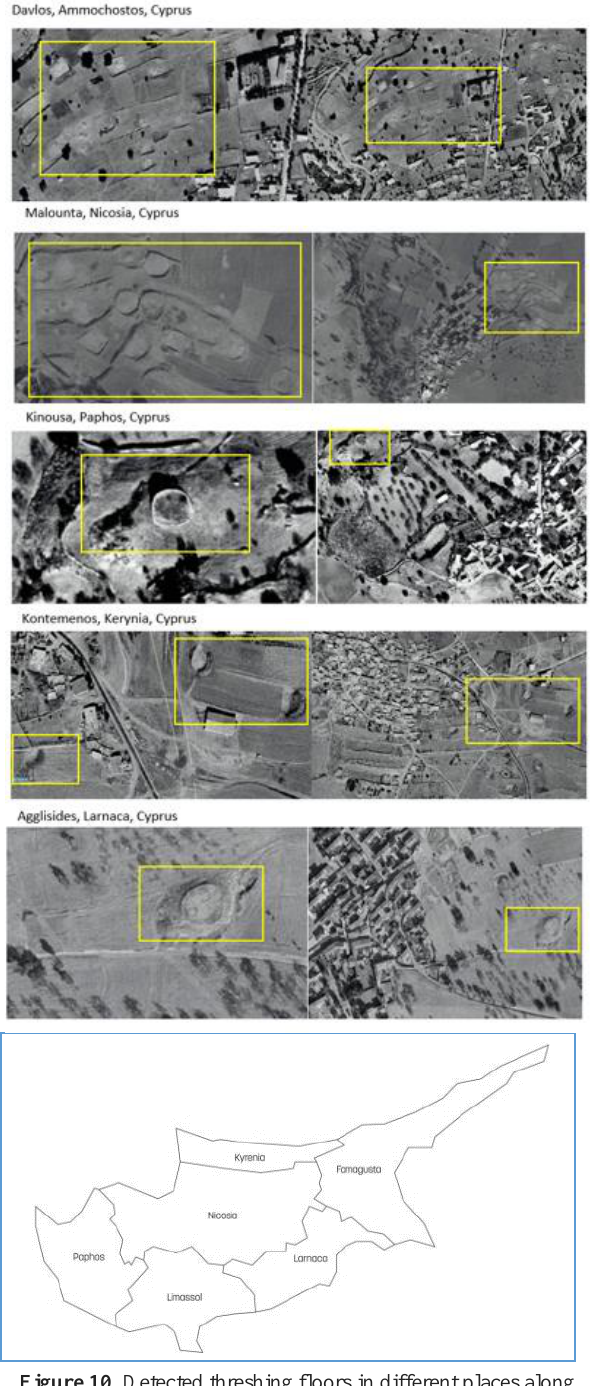
Figure 10 . Detected threshing floors in different places along the 6 different Cyprus districts which are shown on the overview